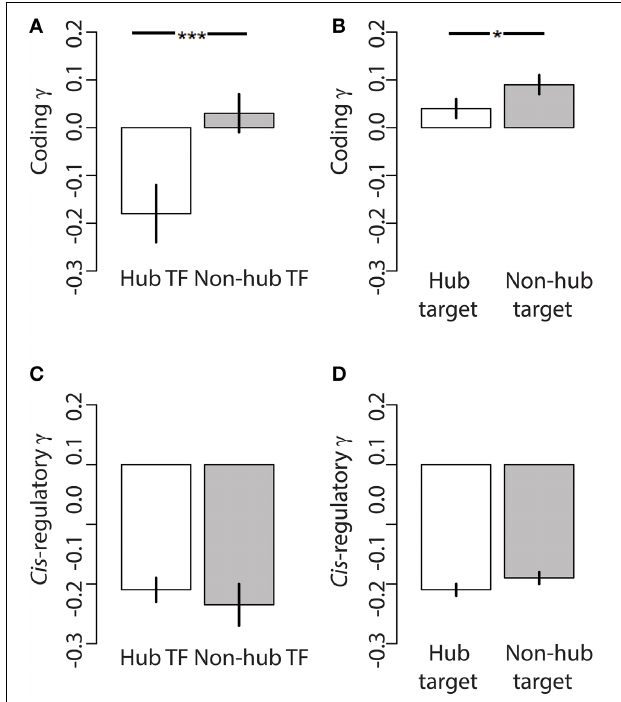
FIGURE 2 | Connectedness reduces the seletion coefficient on coding but not regulatory mutations across the honey bee TRN. Both (A) hub TFs and (B) hub target genes have signficantly stronger negative selection on their coding sequences (i.e., lower coding γ ) relative to non-hub TFs and non-hub targets, respectively. The selection coefficient on putative cis- regulatory sequences of (C) hub TFs and (D) hub target genes do significantly differ relative to non-hub TFs and non-hub targets, respectively. Bars indicate Mean ± SEM, ∗ p < 0 . 05, ∗∗∗ p < 0 .